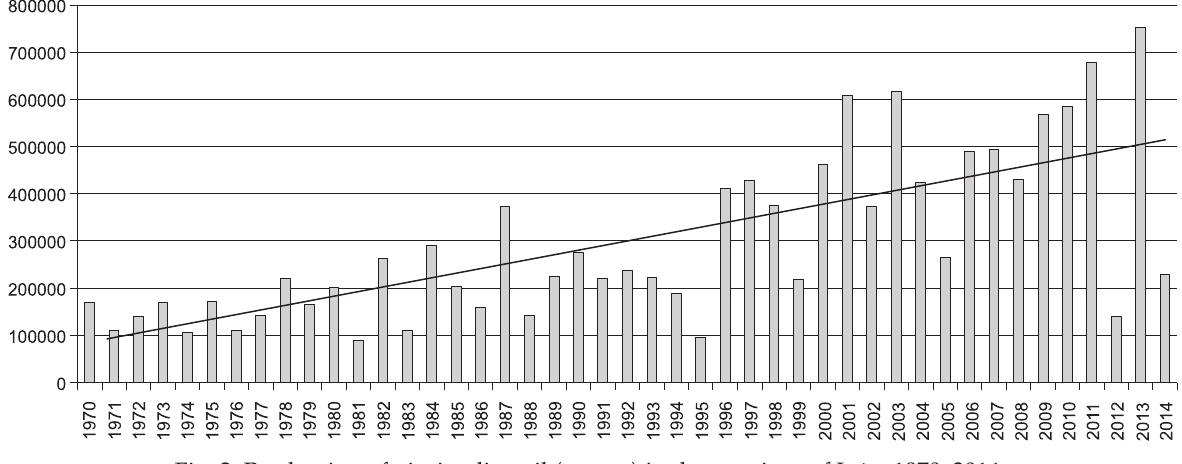
Fig. 2. Production of virgin olive oil (tonnes) in the province of Jaén, 1970–2014.